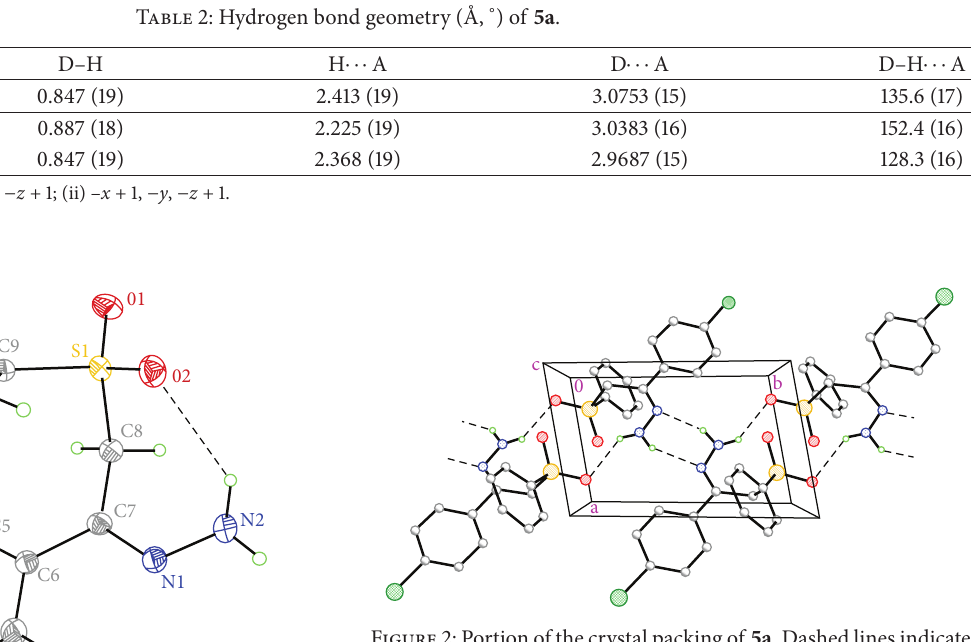
Figure 2: Portion of the crystal packing of 5a . Dashed lines indicate N2–H2 ⋅ ⋅ ⋅ N1 and N2–H1 ⋅ ⋅ ⋅ O1 intermolecular hydrogen bonds. H atoms not involved in hydrogen bonding are omitted for